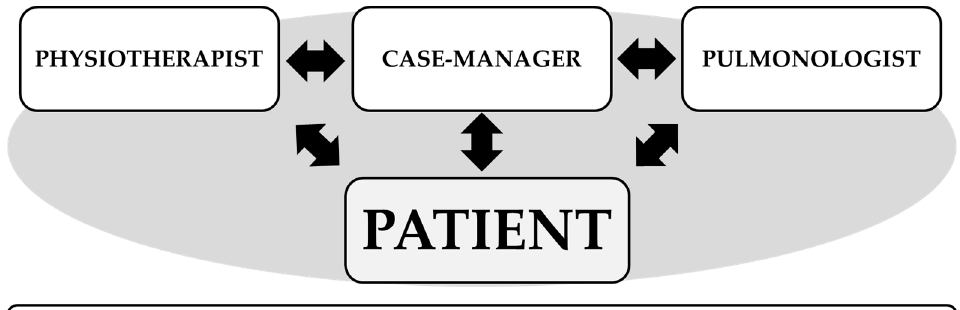
Figure 1. Members of the reabilitAR program.